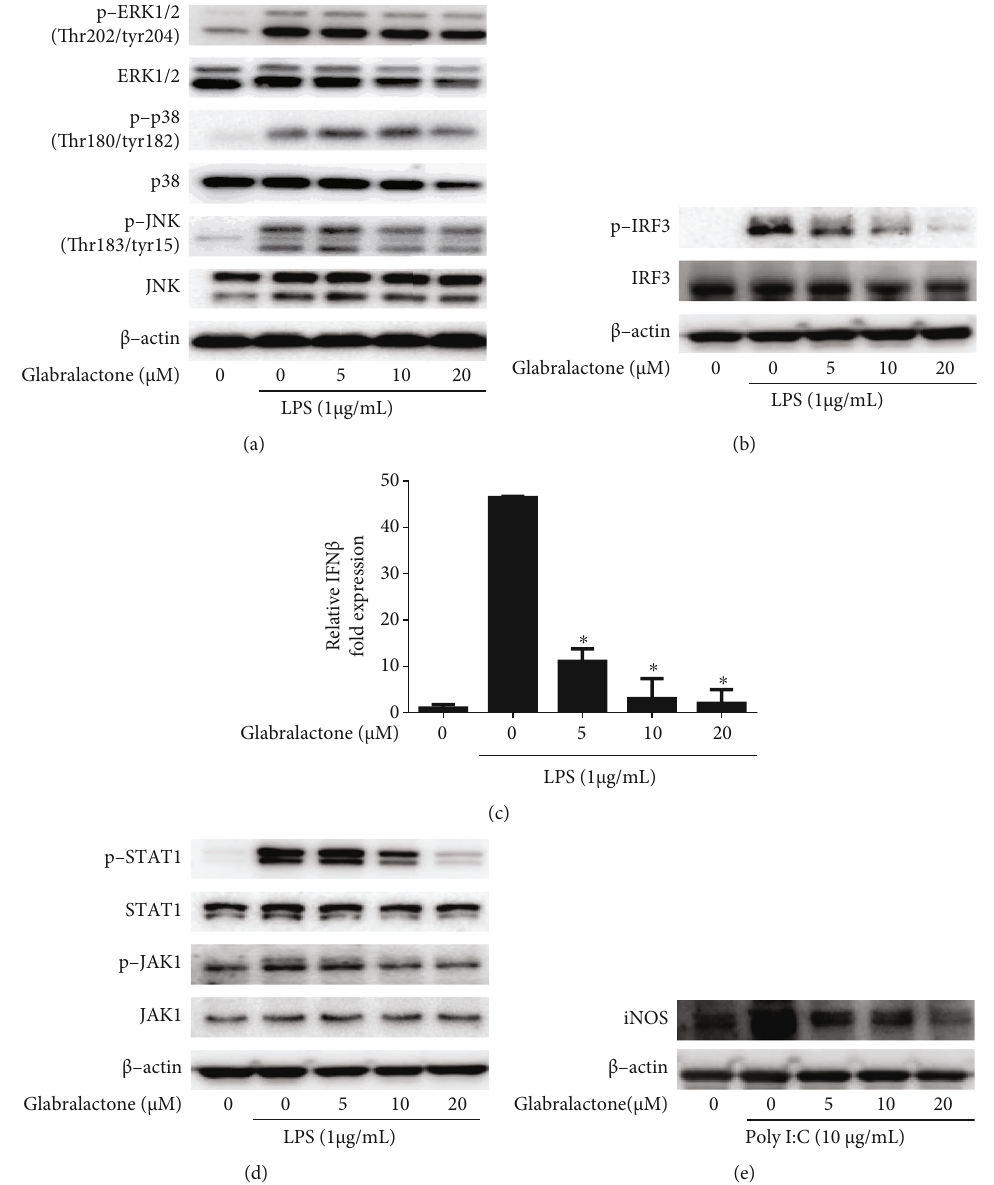
Figure 5: E ff ect of glabralactone on the TRIF-dependent TLR signaling pathway. (a) E ff ect of glabralactone on the protein expression of MAPK signaling in LPS-stimulated RAW 264.7 cells. Cells were pretreated with glabralactone for 30min and then stimulated with LPS (1 μ g/mL) for an additional 30min. Proteins were analyzed by Western blotting. (b) E ff ect of glabralactone on the protein expression of IRF3 in LPS-stimulated RAW 264.7 cells. Cells were pretreated with glabralactone for 30min and then stimulated with LPS (1 μ g/mL) for 3h. After incubation, total proteins were extracted, and IRF3 and p-IRF3 protein expressions were analyzed by Western blotting. (c) E ff ect of glabralactone on the mRNA expression of IFN- β in LPS-stimulated RAW 264.7 cells. Cells were pretreated with glabralactone for 30min and then stimulated with LPS (1 μ g/mL) for 4h. The mRNA expression of IFN- β was analyzed by using reverse transcription and real-time PCR. ∗ p < 0 : 05 . (d) E ff ect of glabralactone on the JAK/STAT pathway protein expression in LPS-stimulated RAW 264.7 cells. Cells were pretreated with glabralactone for 30min and then stimulated with LPS (1 μ g/mL) for 3h. After incubation, total proteins were extracted, and protein level was analyzed by Western blotting. (e) E ff ect of glabralactone on poly (I:C)-induced iNOS expression. RAW 264.7 cells were pretreated with glabralactone for 30min and then stimulated with poly I:C (10 μ g/mL) for 12h. After incubation, total proteins were extracted, and iNOS protein level was analyzed by Western blotting. β -Actin was used as an internal standard. Glabralactone was dissolved in 100% DMSO, and the fi nal concentration of DMSO was adjusted to of IRF3), but the pretreatment of glabralactone for 30min prior to LPS stimulation e ff ectively downregulated the in Figure 5(b), LPS treatment (1 μ g/mL) for 3 h signi fi - expression of p-IRF3 in a concentration-dependent manner. cantly enhanced the expression of p-IRF3 (activation form